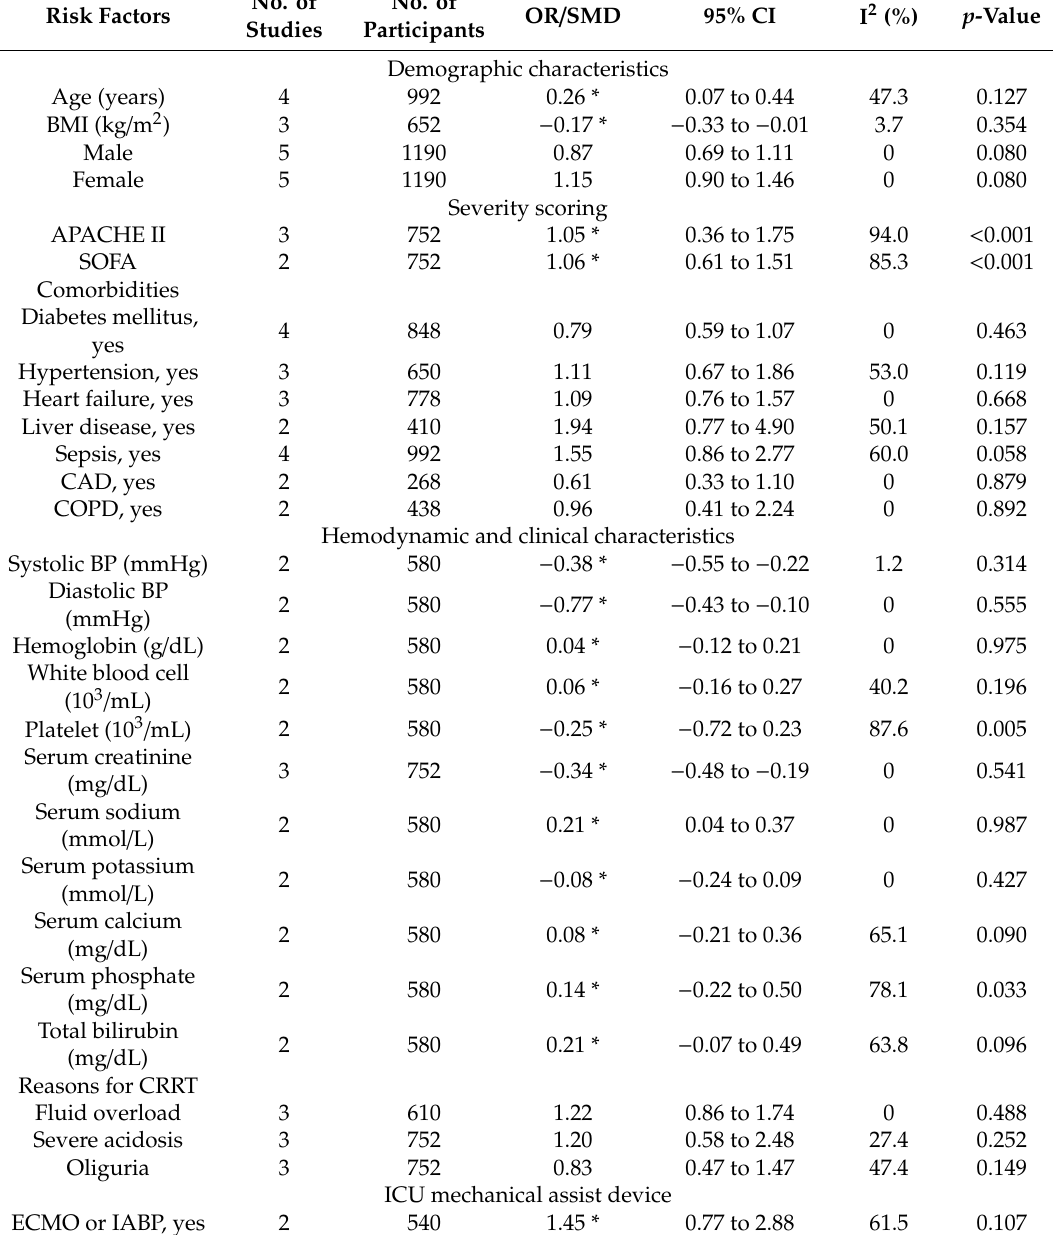
Table 2. Risk factors for hospital mortality among critically ill patients who received